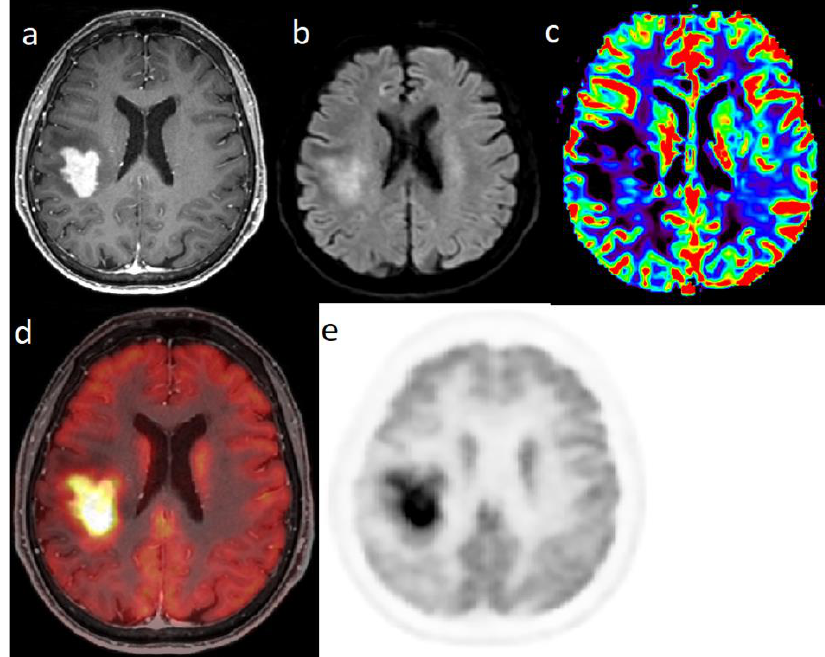
Figure 5. Characterization of a single right parietal brain lesion in an 81-year-old woman. Post-enhancement T1-weighted MRI ( a ) showed an intense increasing contrast enhancement; diffusion weighted imaging ( b ) showed a hypersignal and the there was no hyperperfusion in perfusion- weighted imaging ( c ). [18F]FDG PET (fused with T1-weighted MRI ( d ) and PET only ( e )) showed a highly intense uptake: SUVmax = 37. Pathological analysis of biopsy samples confirmed a PCNSL (type